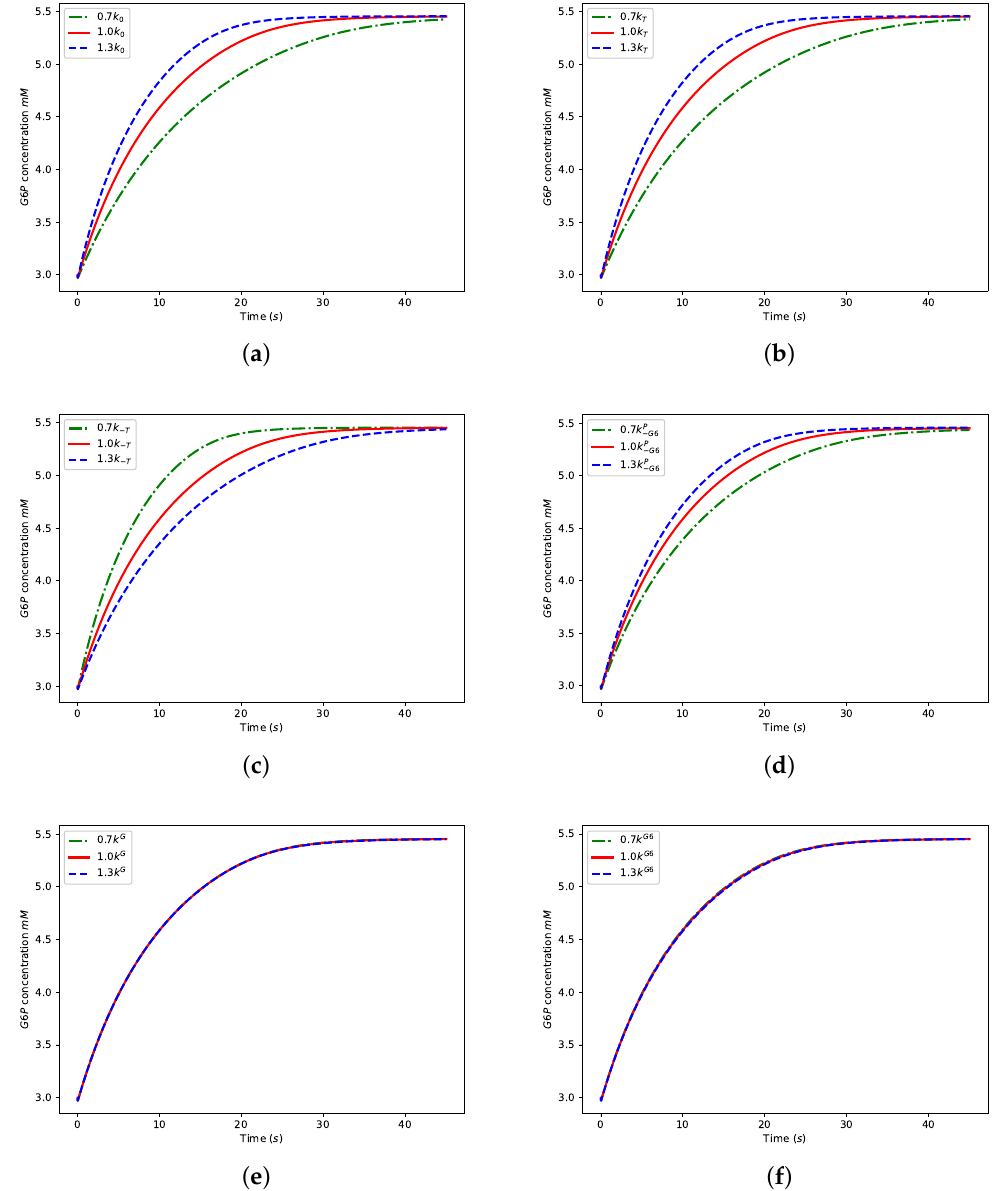
Figure 11. Numerical solutions of the model equations for a high level of P i . The graphs show the concentration of G 6 P as a function of time, and the parameter values used can be found in the main body of the text. The solutions displayed help evaluate the sensitivity of the model output to the parameters ( a ) k 0 , ( b ) k T , ( c ) k − T , ( d ) k P −